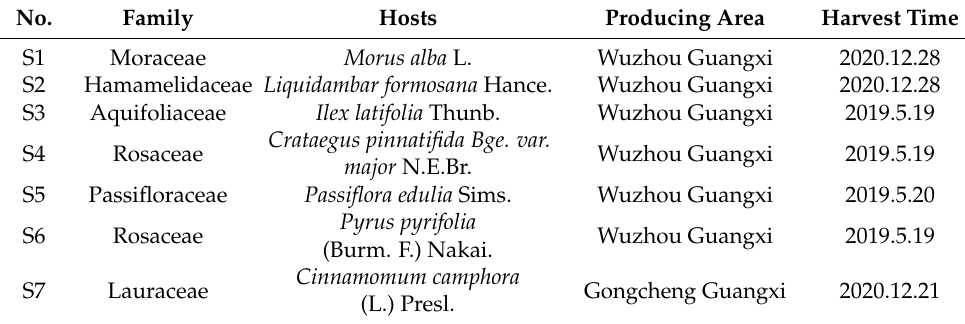
Table 3. Information of Taxilli Herba samples from 7 different